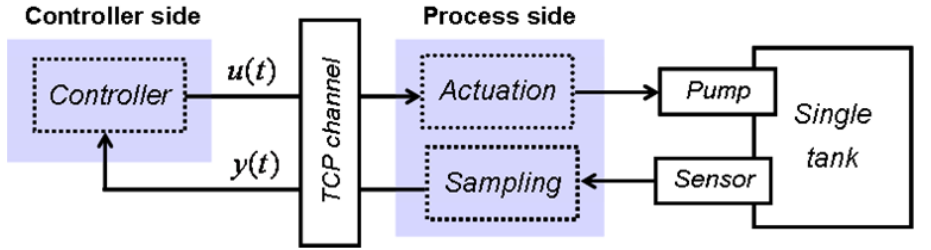
Figure 1. Diagram illustrating the architecture used in the development of the experimental framework. The controller side is composed by one process: the PI controller. The process side contents two processes: a loop to receive the control actions and apply them to the pump by a ZOH; and a second one that reads the level of the single tank and sends these readings to the